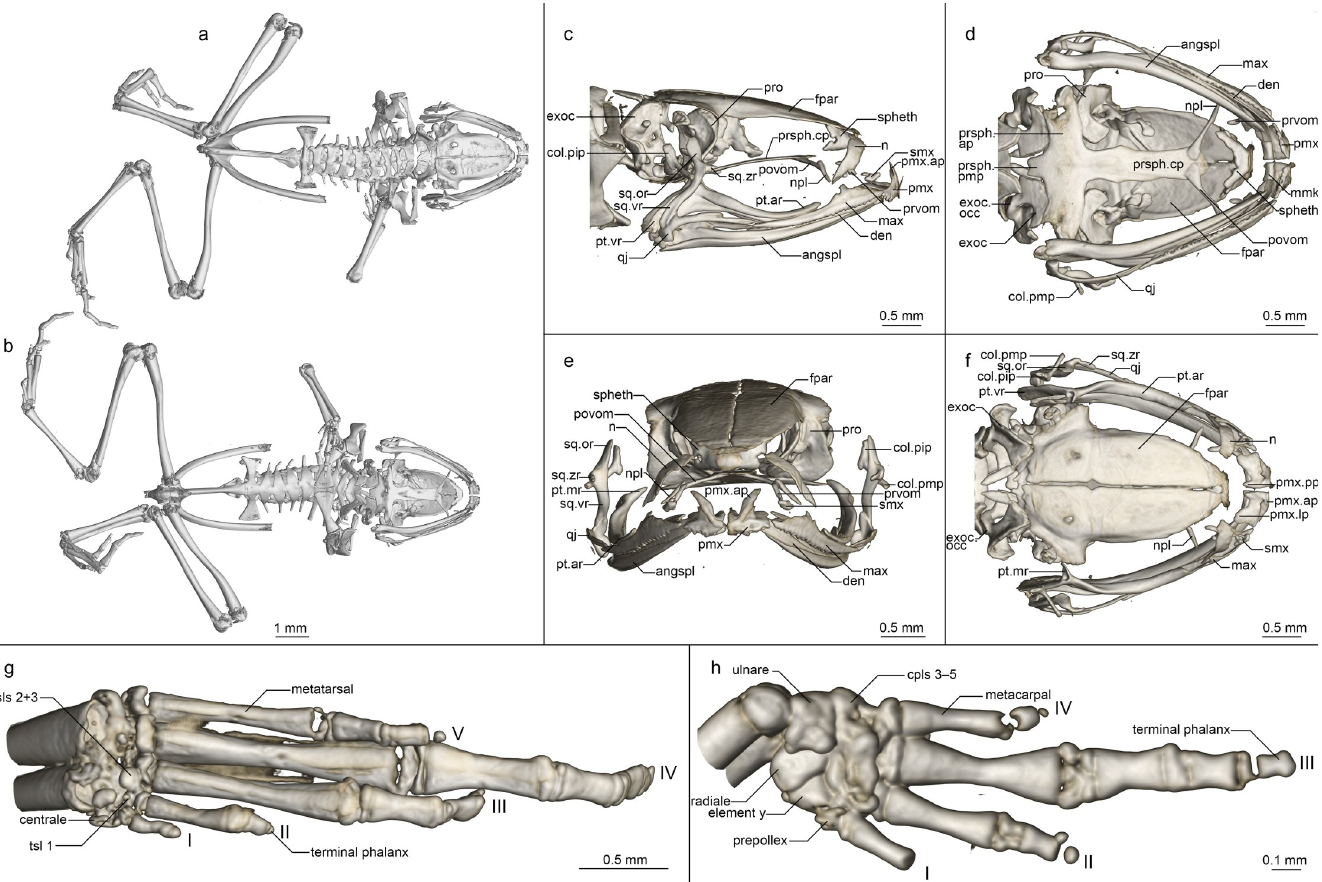
Fig 8. Osteology of Mini scule gen. et sp. nov. holotype (ZSM 5943/2005). (a, b) Whole skeleton in (a) dorsal and (b) ventral view. (c-f) Skull in (c) lateral, (d) ventral, (e) anterior, and (f) dorsal view. (g) Foot in ventral view. (h) Hand in ventral view. For abbreviations, see Fig